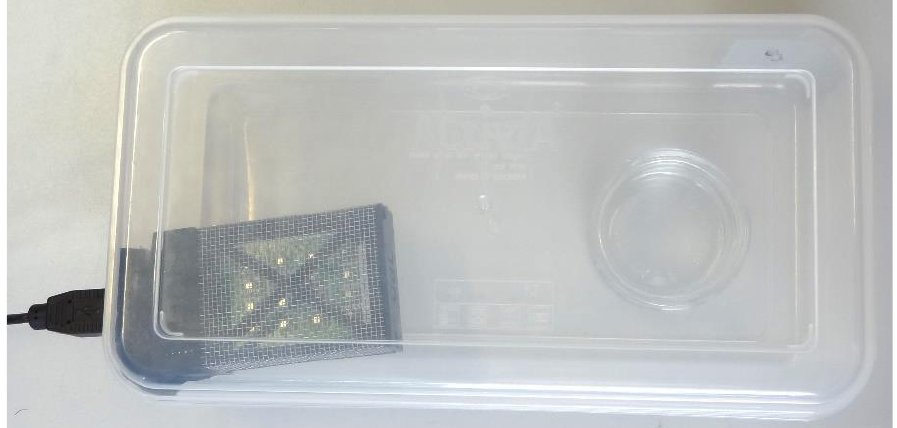
Figure 2. Measurement setup composed of the transparent plastic box, the evaporation glass plate, and the eNose Osmee One.